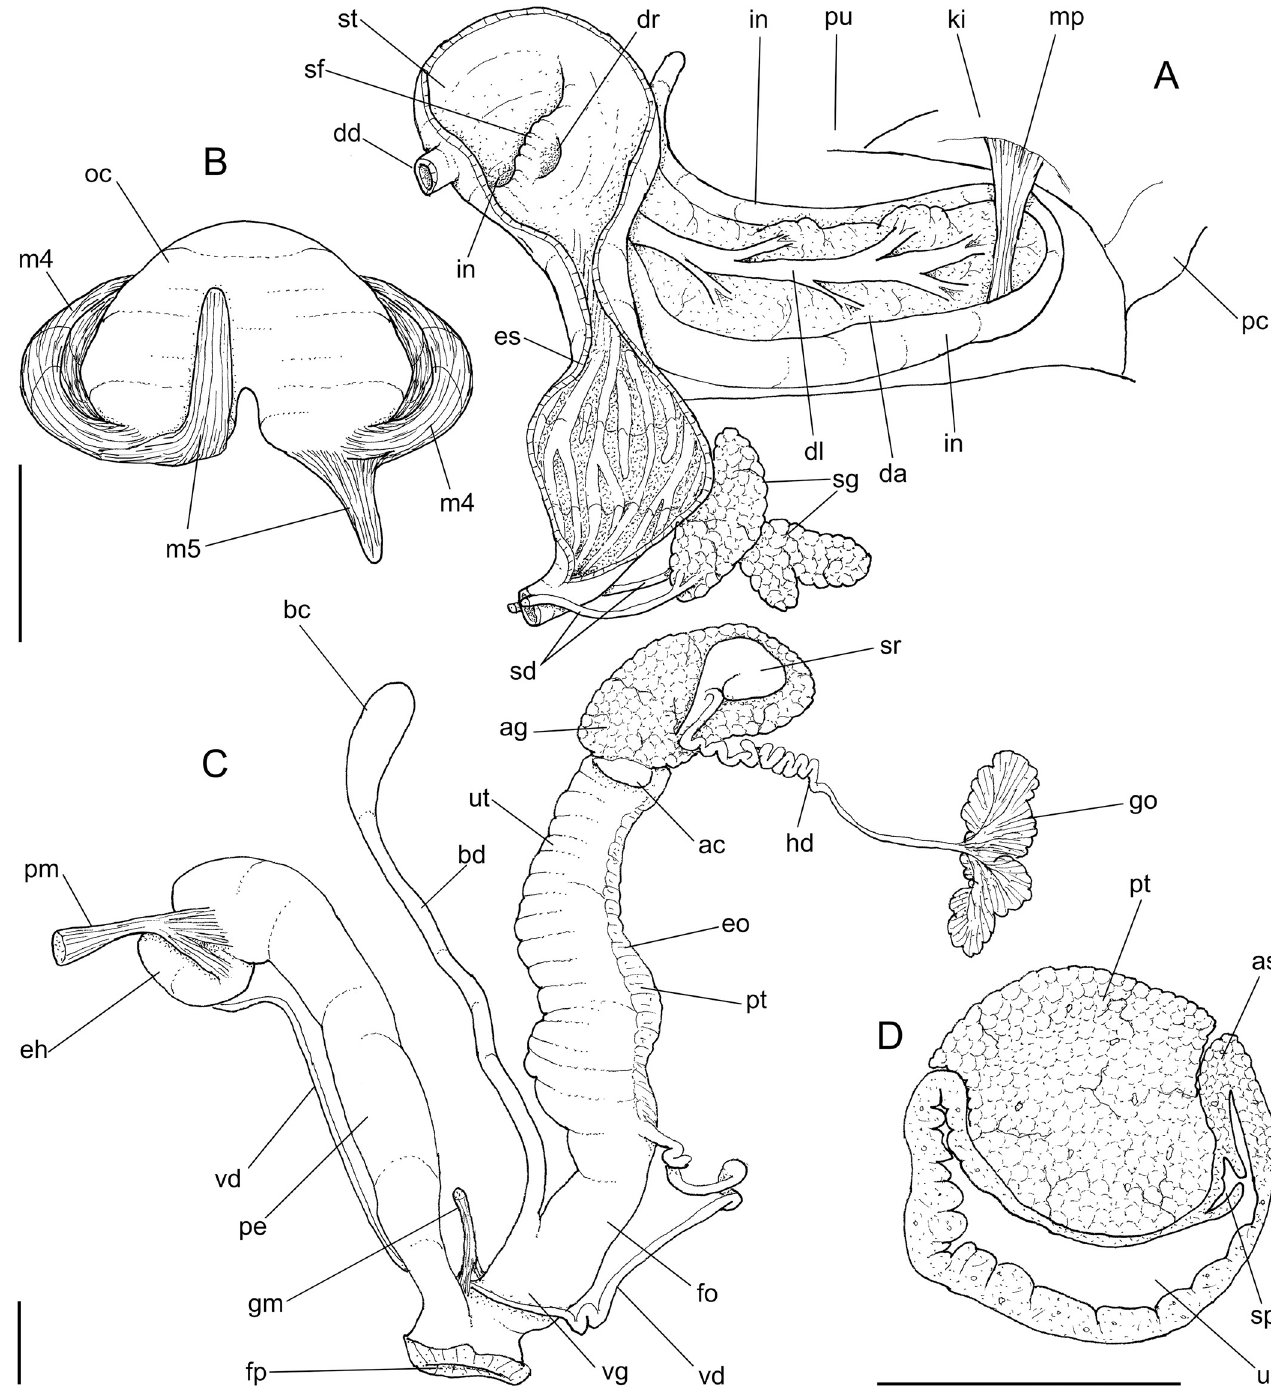
Fig 17. Anthinus savanicus , anatomical drawings. (A) midgut as in situ, ventral view, some adjacent structures or their topology also shown, stomach and esophagus opened longitudinally. (B) odontophore, dorsal view, outer layer of structures removed, pair of odontophore cartilages deflected, both m4 and left m5 (right in Fig) also deflected. (C) genital structures, mostly ventral view, most vas deferens (dv) detached. (D) spermoviduct, transverse section of its middle level. Scales = 2 mm.